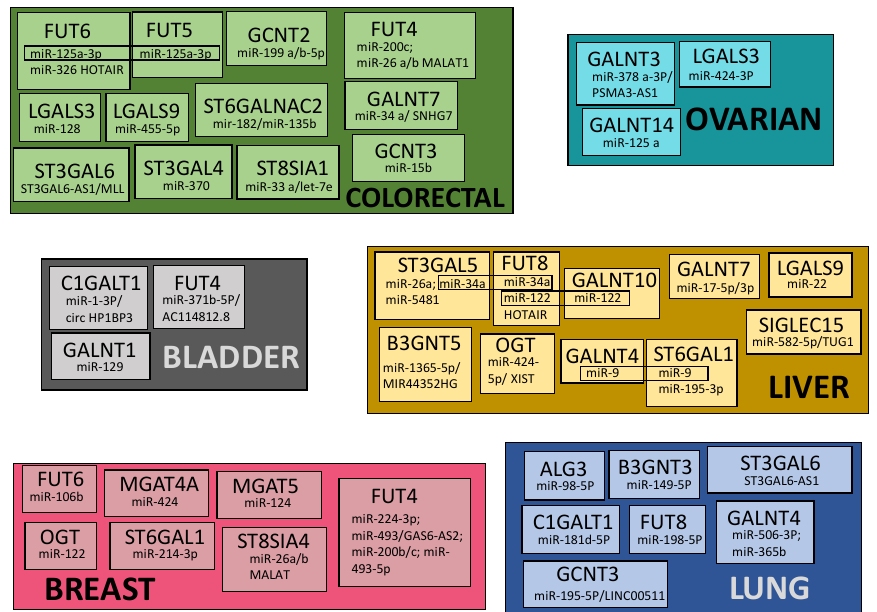
Figure 6. Glycogenes modulated by ncRNAs in different cancer types. Only cancers with at least 3 modulated glycogenes are reported. MiRNAs modulating different enzymes in the same cancer type are